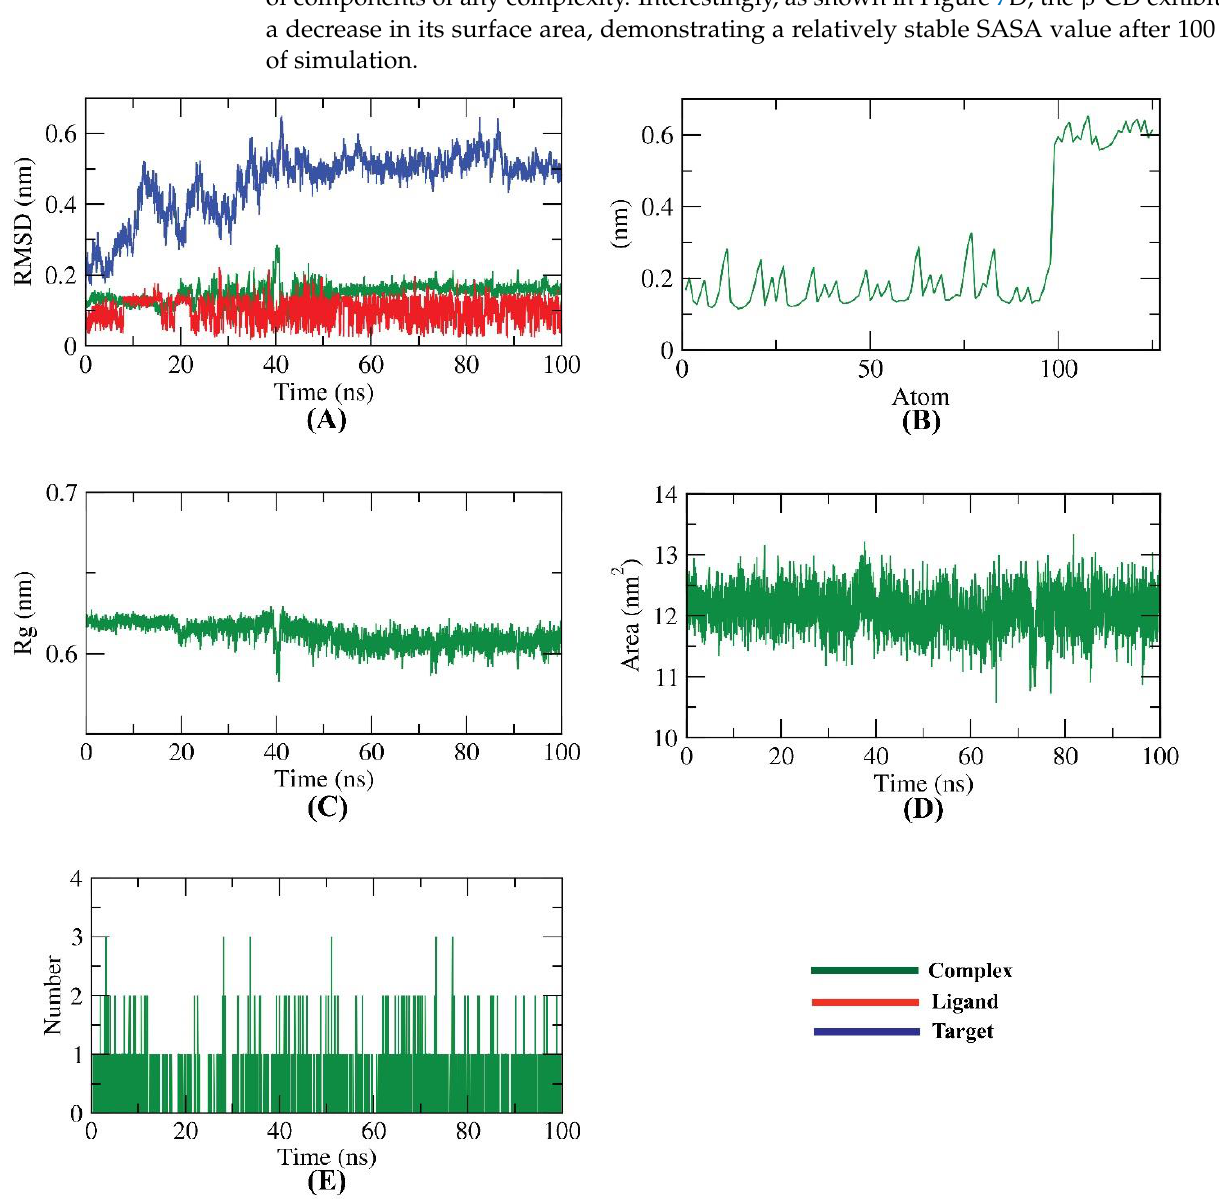
Figure 7. Results of MD simulations of the resveratrol –β -CD complex: ( A ) RMSD, ( B ) RMSF, ( C ) R g , ( D ) SASA, and ( E ) H bonding.